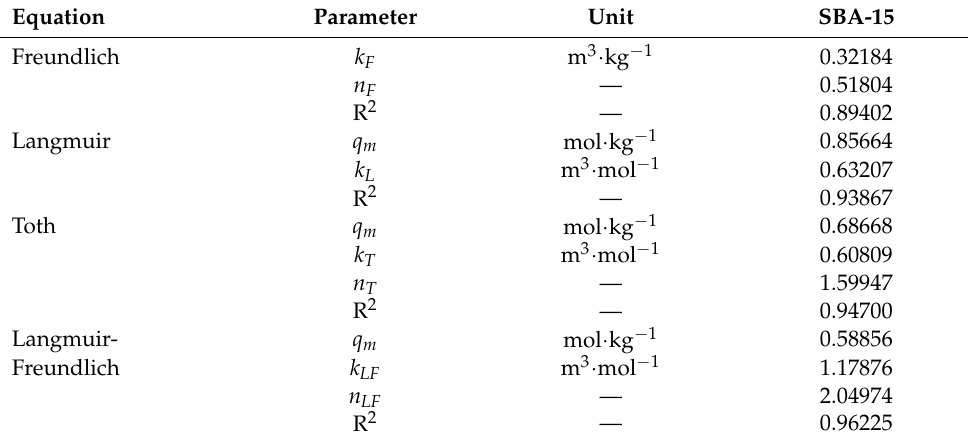
Figure A21. Uptake of Pd(hfac) 2 on SBA-15 at 8.5 MPa and 313 K; experimental data taken from [9]. Table A21. Adsorption isotherm parameters of Pd(hfac) 2 from scCO 2 solution on SBA-15 at 8.5 MPa and 313 K [9].